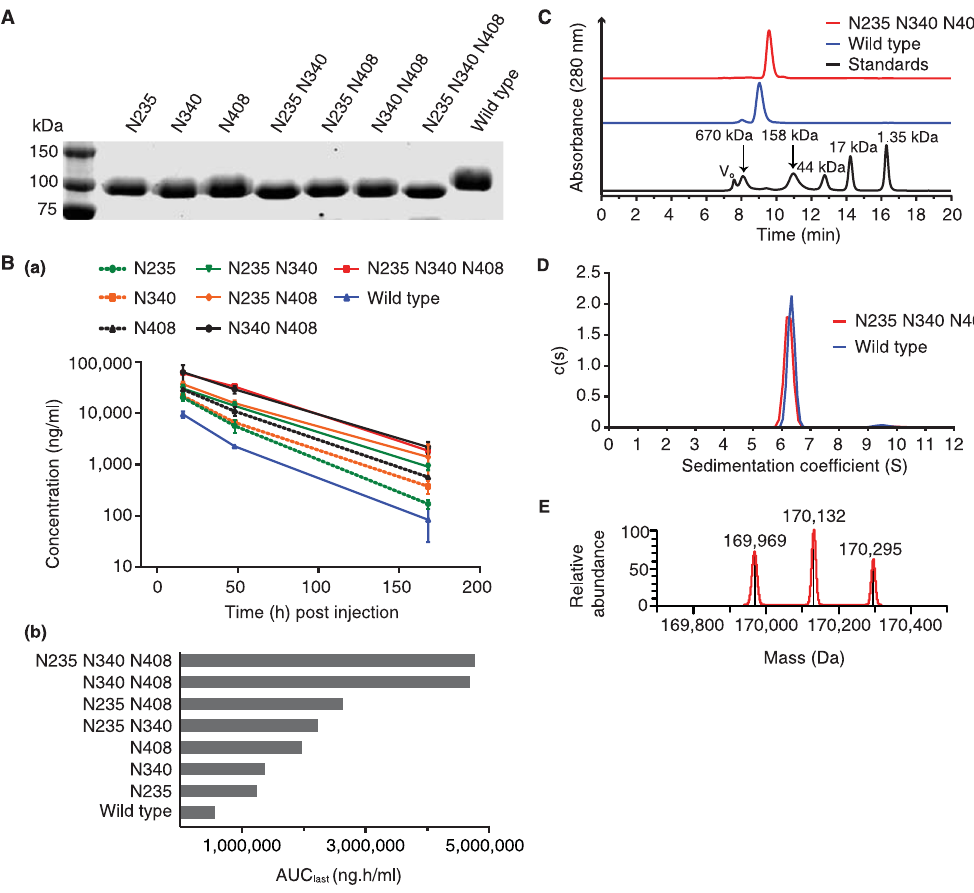
single, double and triple mutants (N > Q) and wild type EphA4 Fc protein clearance in Mus musculus (a) with calculated AUC last values (b). Protein conformation and stability of the triple mutant compared to wild type EphA4 Fc proteins using SEC ( C ) and SV-AUC ( D ). The profiles reveal single predominant peaks for the triple mutant and wild type EphA4 Fc proteins indicating the absence of significantly different sized protein species. The chromatogram for the molecular weight standards has been included in the SEC profile with the mass of the standards noted above the respective peak. (E) Deconvoluted MS spectrum of the intact triple mutant of EphA4 Fc showing the masses of the predominate